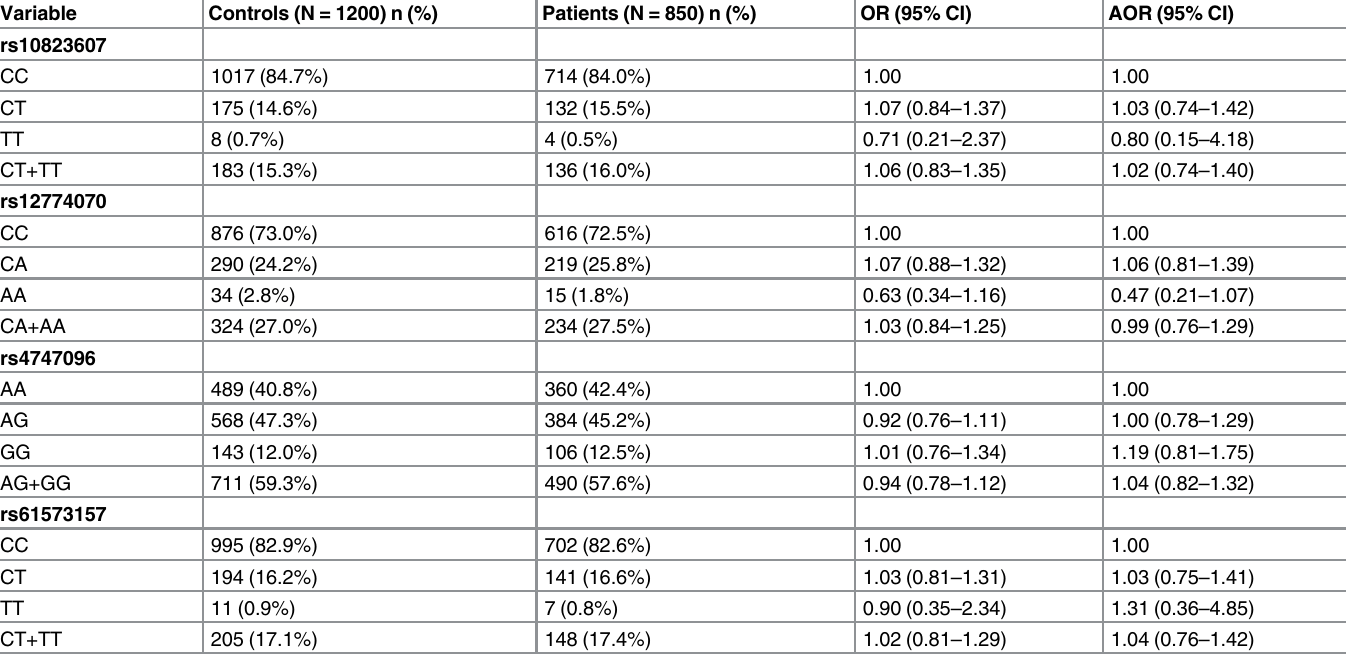
The odds ratio (OR) with their 95% con fi dence intervals were estimated by logistic regression models. The adjusted odds ratio (AOR) with their 95% con fi dence intervals were estimated by multiple logistic regression models after controlling for betel nut chewing, alcohol and tobacco